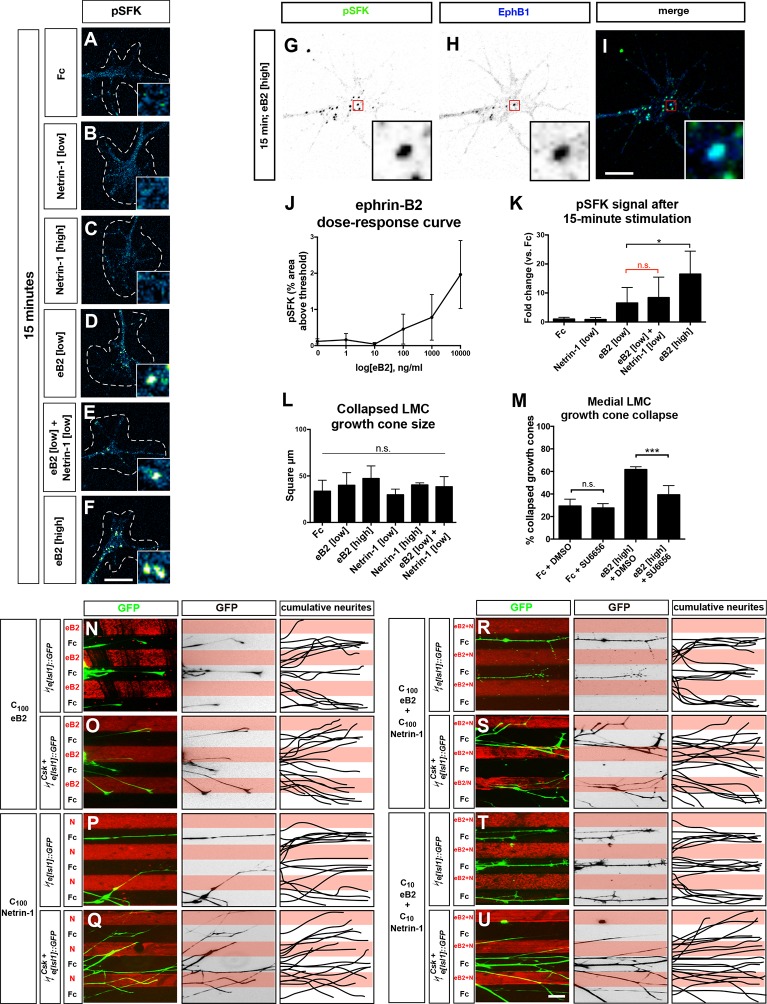
pSFK controls and Csk-electroporated axons in stripe assays.(A–F) Detection of pSFK in LMC growth cones treated for 15 min. (G–I) Co-localization of pSFK and EphB1 receptor clusters in LMC growth cones. (J) pSFK signal increases with increasing dose of ephrin-B2 ligand. (K) A 15-min. treatment with 1 μg/ml ephrin-B2 activates pSFK to the same extent as 1 μg/ml ephrin-B2 + 0.3 μg/ml Netrin-1, but not as much as 10 μg/ml ephrin-B2. Statistical significance computed using one-way ANOVA and Sidak’s multiple comparisons test; N ≥ 3, n ≥ 10 growth cones per condition per experiment. (L) Area of collapsed growth cones analyzed for pSFK quantification. Statistical significance computed using one-way ANOVA. (M) Medial LMC growth cones of e[Isl1]::GFP-electroporated explants collapse in response to a high dose of ephrin-B2 (10 μg/ml), and this can be blocked by including 0.1 μM SU6656 with the ligand. Statistical significance computed using Fisher’s exact test; N = 3, n > 190 growth cones per condition. (N–U) Left panels: medial (GFP+) LMC neurites of e[Isl1]::GFP-electroporated explants on C100 eB2-Fc/Fc (N), C100 N/Fc (P), C100 eB2-Fc+N/Fc (R), and C10 eB2-Fc+N/Fc (T), and Csk and e[Isl1]::GFP-co-electroporated explants on C100 eB2-Fc/Fc (O), C100 N/Fc (Q), C100 eB2-Fc+N/Fc (S), and C10 eB2-Fc+N/Fc (U). Middle panels: inverted images where GFP signal is dark pixels overlaid on substrate stripes. Right panels: superimposed images of five representative explants from each experimental group highlighting the distribution of LMC neurites. Images correspond to the experiments in Figure 7. eB2, ephrin-B2-Fc; LMC, lateral motor column; N, Netrin-1; SFK, Src family kinase; All error bars = SD; n.s. = not significant; ***: p<0.001; *: p<0.05; scale bars: (A–F) 8 μm; (G–I) 6 μm; (N–U) 50 μm.